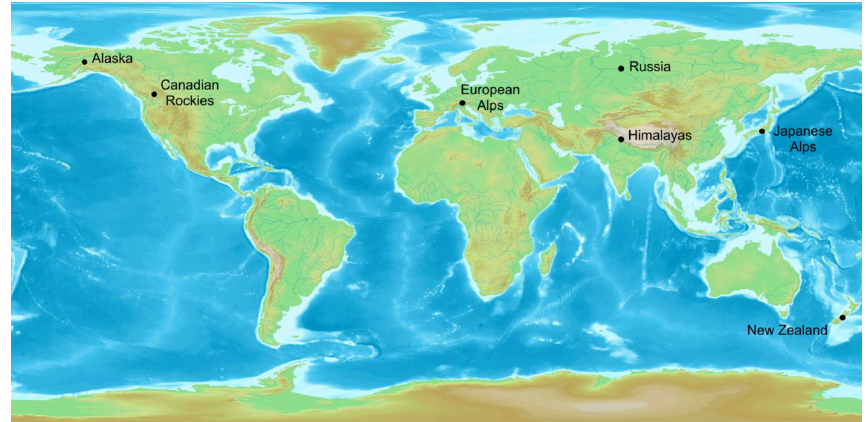
Figure 1. Locations where most braided rivers occur globally. Map base layer image attribution: “World Map-A non-Frame” is licensed under CC BY-SA 3.0.